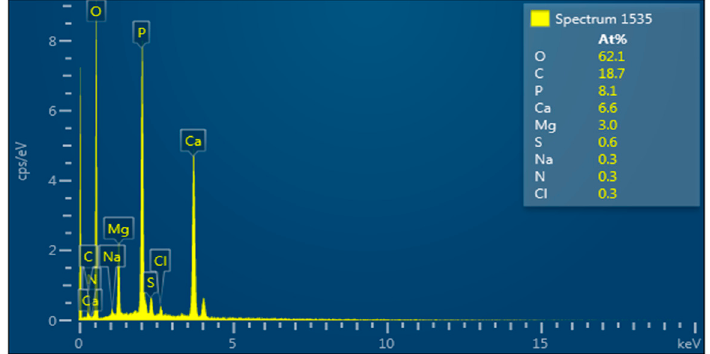
Figure 8. Elemental analysis of bioflocculant.